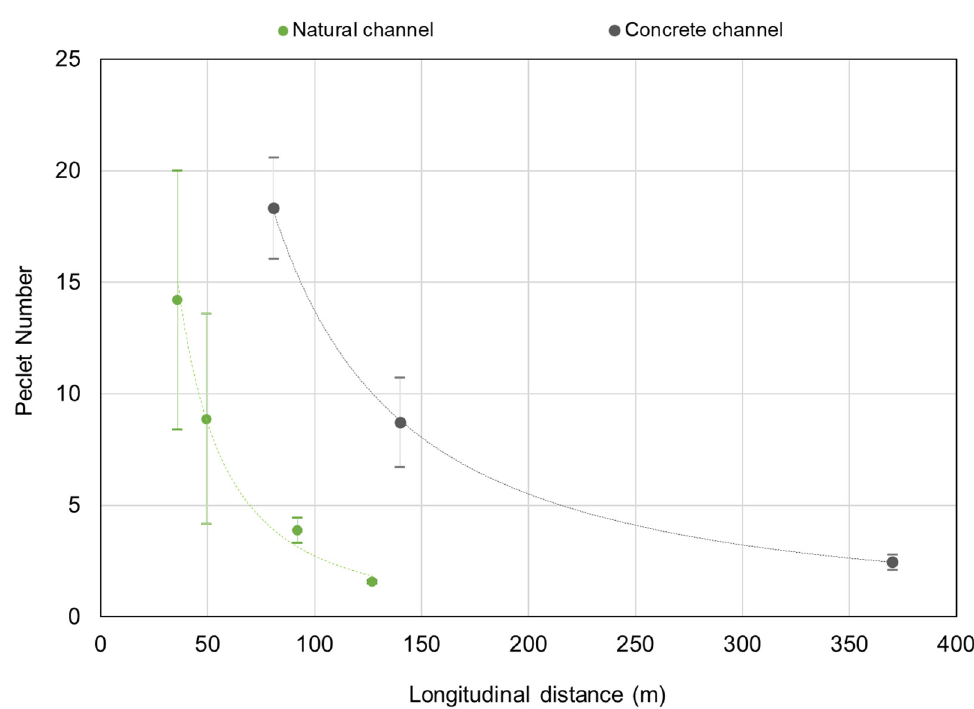
Figure A2. Downstream trends in Peclet Number in the concrete (grey) and natural (green) chan- nels. The solid dots are the mean values for each measurement location, and the whiskers show ± 1 standard deviation.